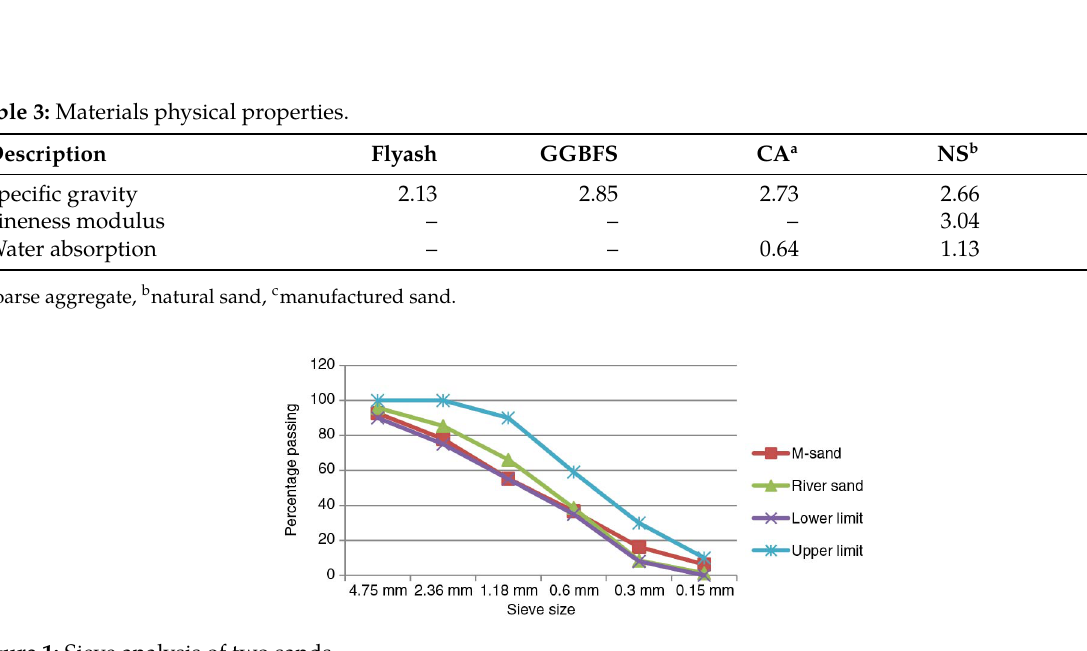
Figure 1: Sieve analysis of two